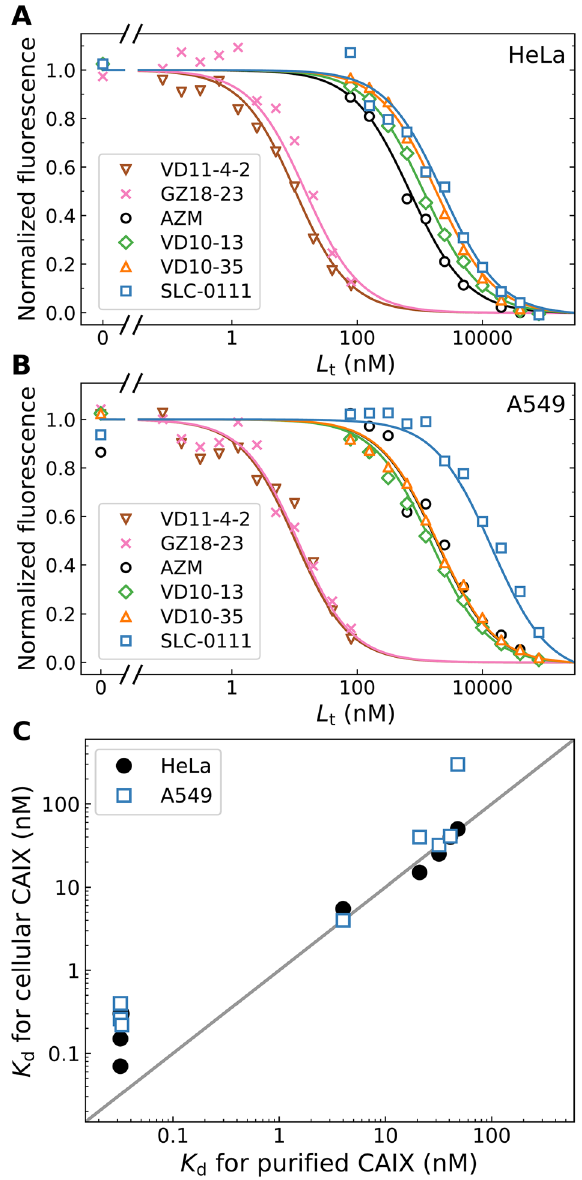
Figure 12. Competitive dosing of several CA inhibitors to HeLa ( A ) and A549 ( B ) cells grown under hypoxia in the presence of constant 10 nM concentration of fluorescein-labeled GZ19-32. ( C ) Comparison of K d values for compound binding to CAIX expressed on live cell surface with the values obtained for compound binding to the purified CAIX by FTSA. Two cancer cell lines were tested—HeLa (filled circles) and A549 (open blue squares). The solid diagonal line shows a would-be perfect match between the two approaches to determine compound affinities for